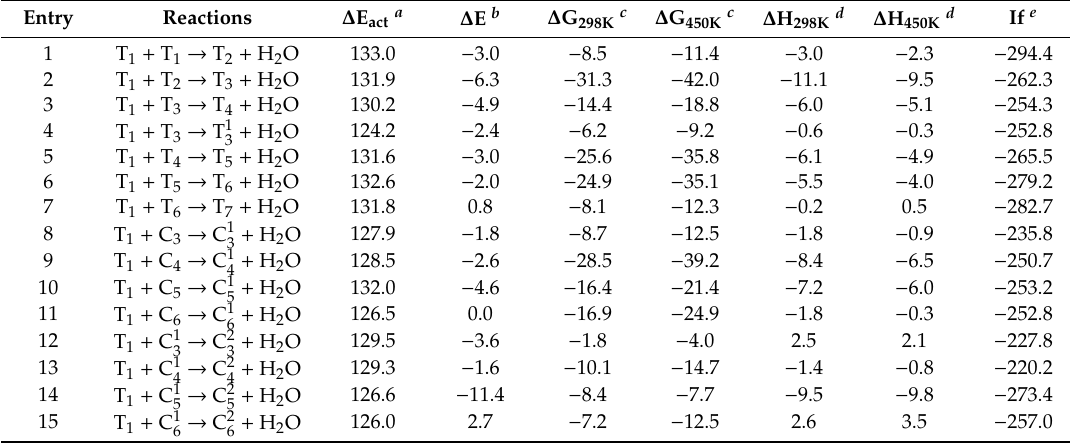
Table 1. Energy profile (kJ / mol) for the formation of linear oligomers through the AAM mechanism. Entry